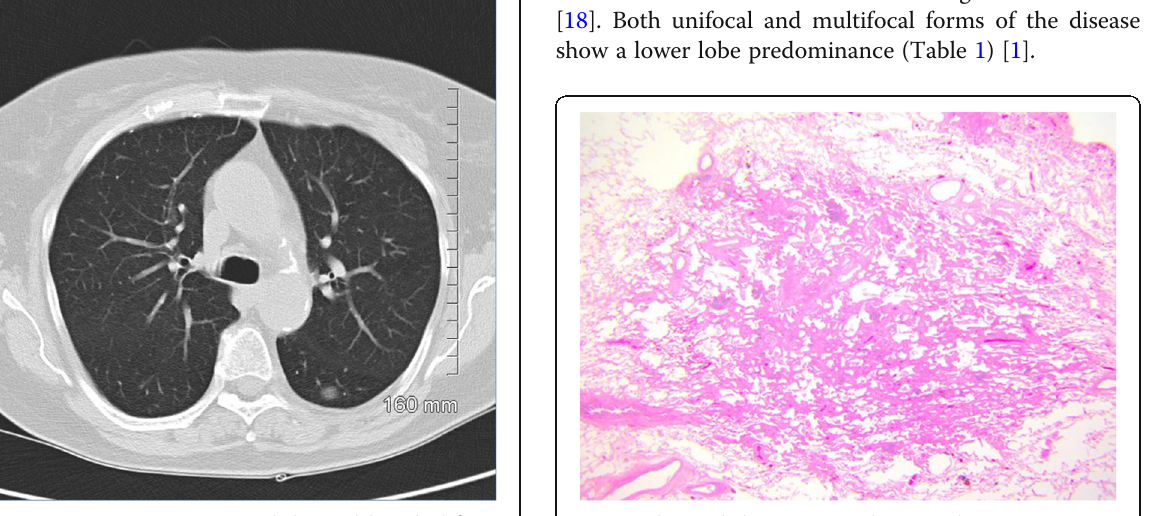
Fig. 2 AIS histopathology: a 10-mm diameter adenocarcinoma pure lepidic growth, no invasion seen (H&E, 2